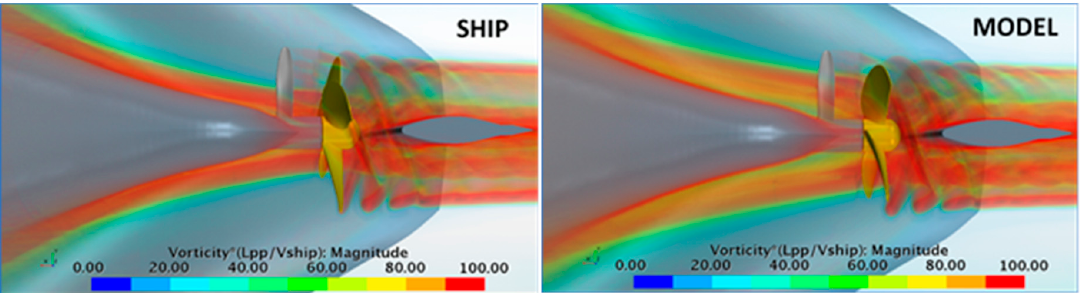
Figure 25. Comparison of power savings due to ESD installation.